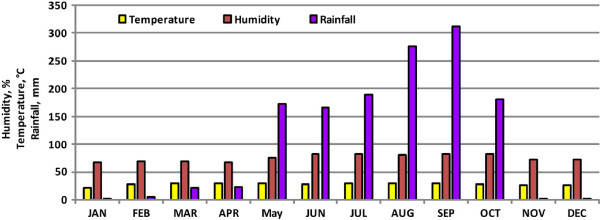
Total number of patients suffering from various diseases and dengue infection between 2006 and 2010. Number of suspected dengue cases (cases with clinical symptoms) reported and the total number of patients. Figure shows that dengue cases reported each year vary in the study area.